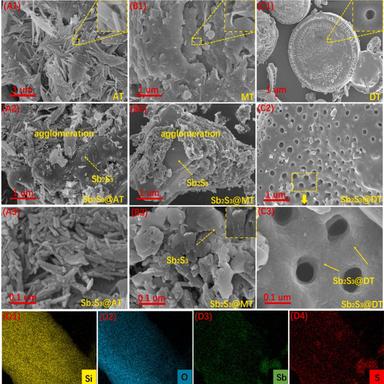
SEM images of (A1) attapulgite, (B1) diatomite, and (C1) montmorillonite. SEM images of (A2-A3) Sb2S3@AT, (B2-B3) Sb2S3@MT, (C2-C3) Sb2S3@DT. Mapping images (D1-D4) of Sb2S3@DT.